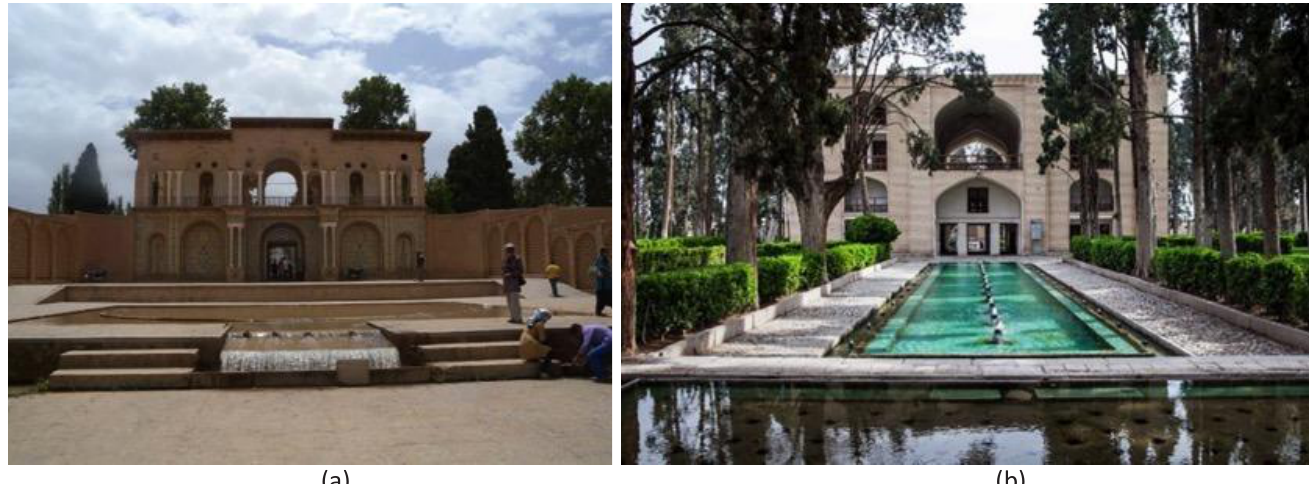
Figure 7. (a): A view of Shahzade-Mahan pavilion, Kerman. Photo by: Maite Elorza from Flickr; (b) A view of Fin garden central Pavilion, Kashan. Photo by: Ninara from Flickr